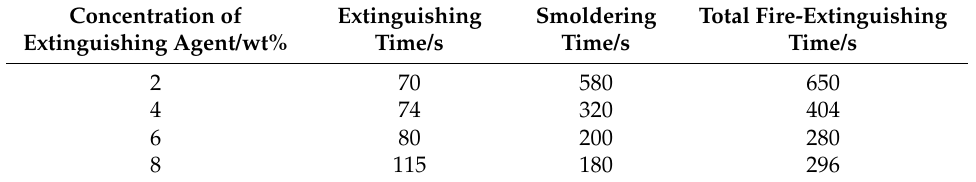
Table 1. Fire extinguishing performance of the four samples.